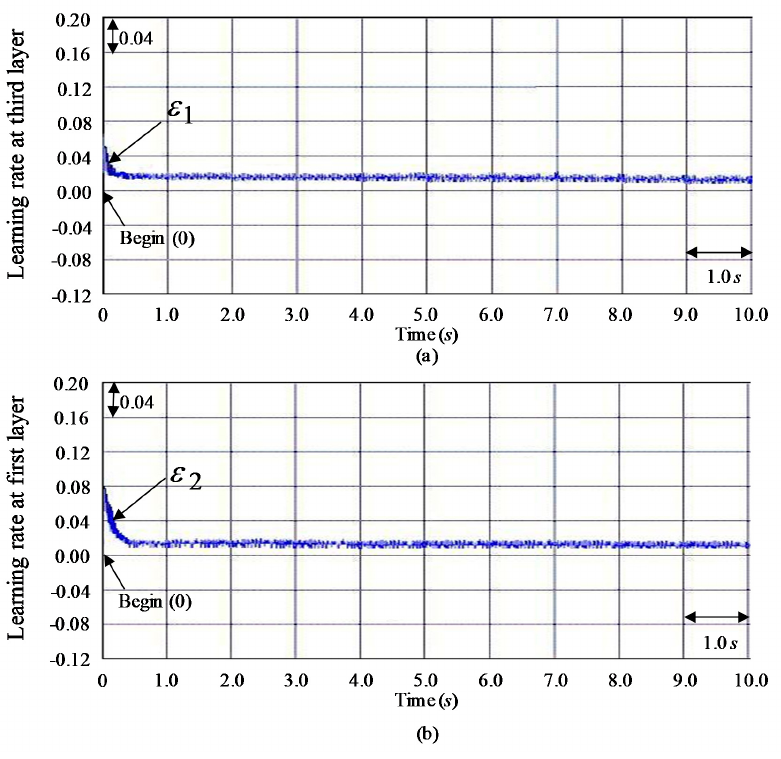
Figure 15. Tested results at the tested Event E1 case by using the controller CT3: ( a ) convergent response of learning rate 1 ε , ( b ) convergent response of learning rate 2 ε .